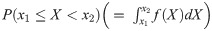
Concept and definitions.A) A cellular trait is considered as a random variable X with density function f. The probability P(x1≤X<x2)( = ∫x1x2f(X)dX) that one cell expresses X at a value comprised between x1 and x2 is given by the shaded area. B) f differs between individuals because of environmental and genetic factors.